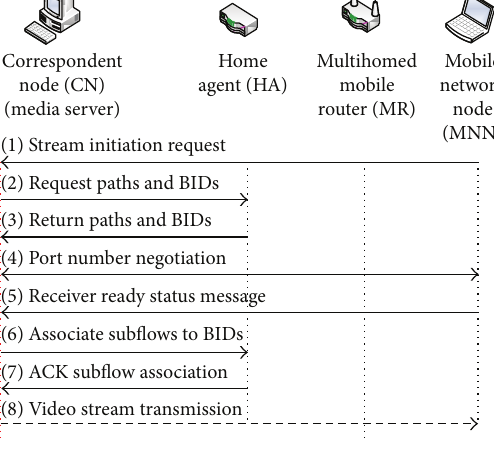
Figure 4: Session